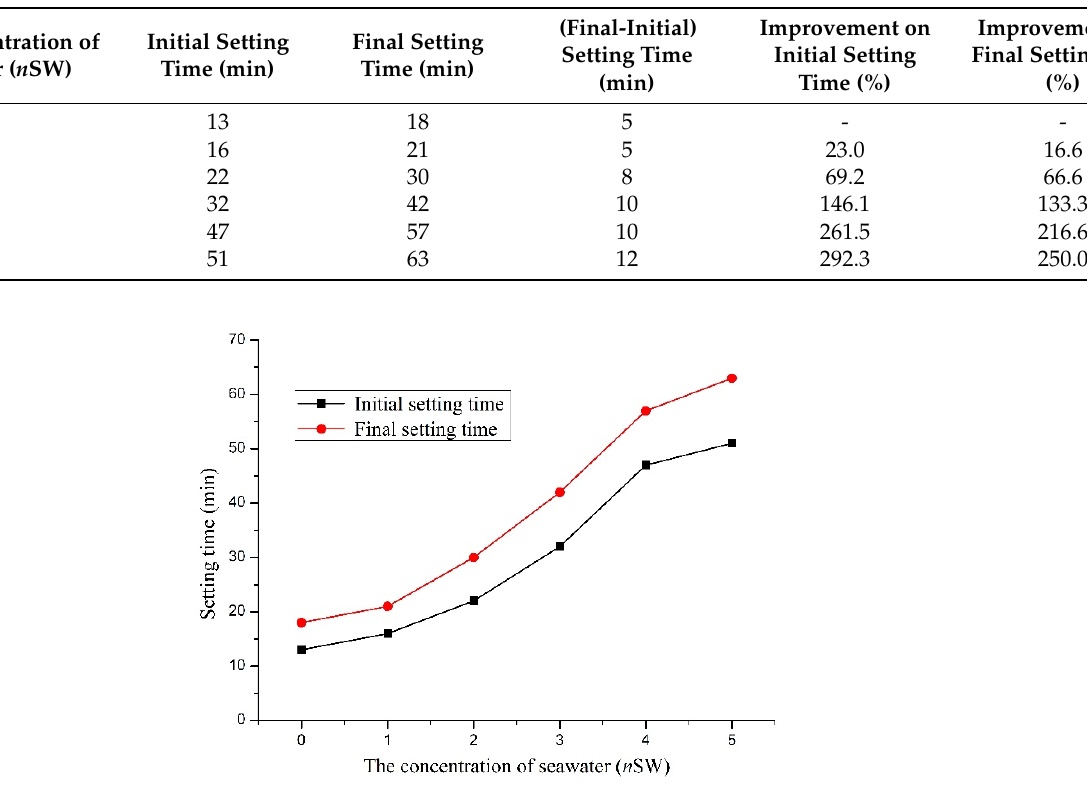
Figure 4. The influence of the seawater concentration on the setting time of CSA cement.